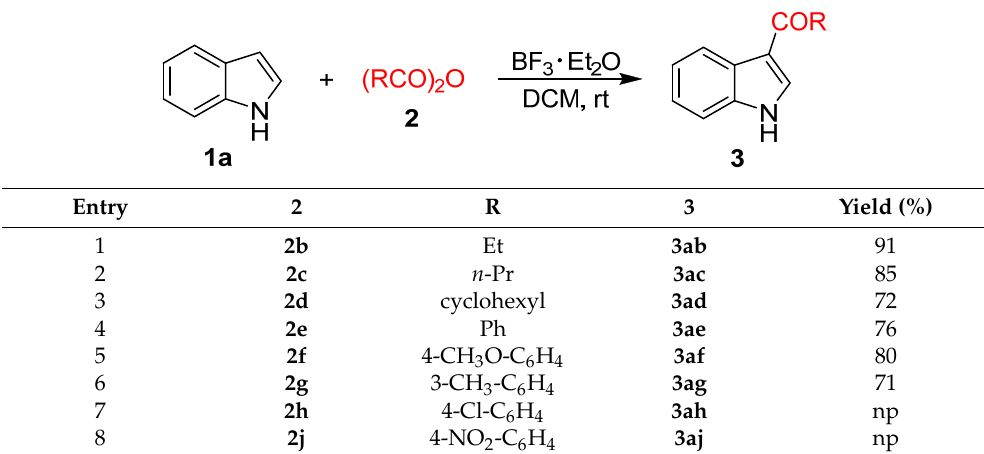
Table 2. Scope of anhydrides. Table 2. Scope of